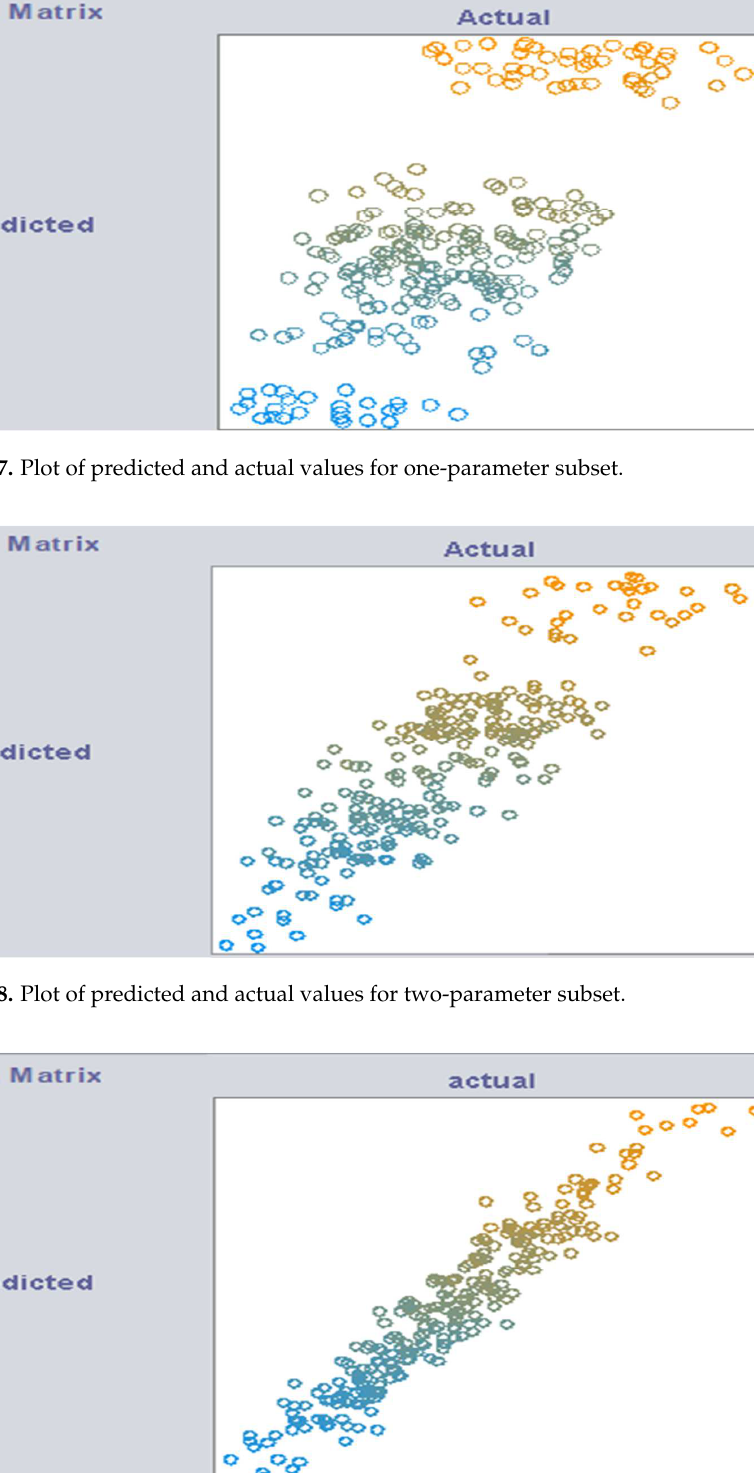
Figure 9. Plot of predicted and actual values for three-parameter subset.